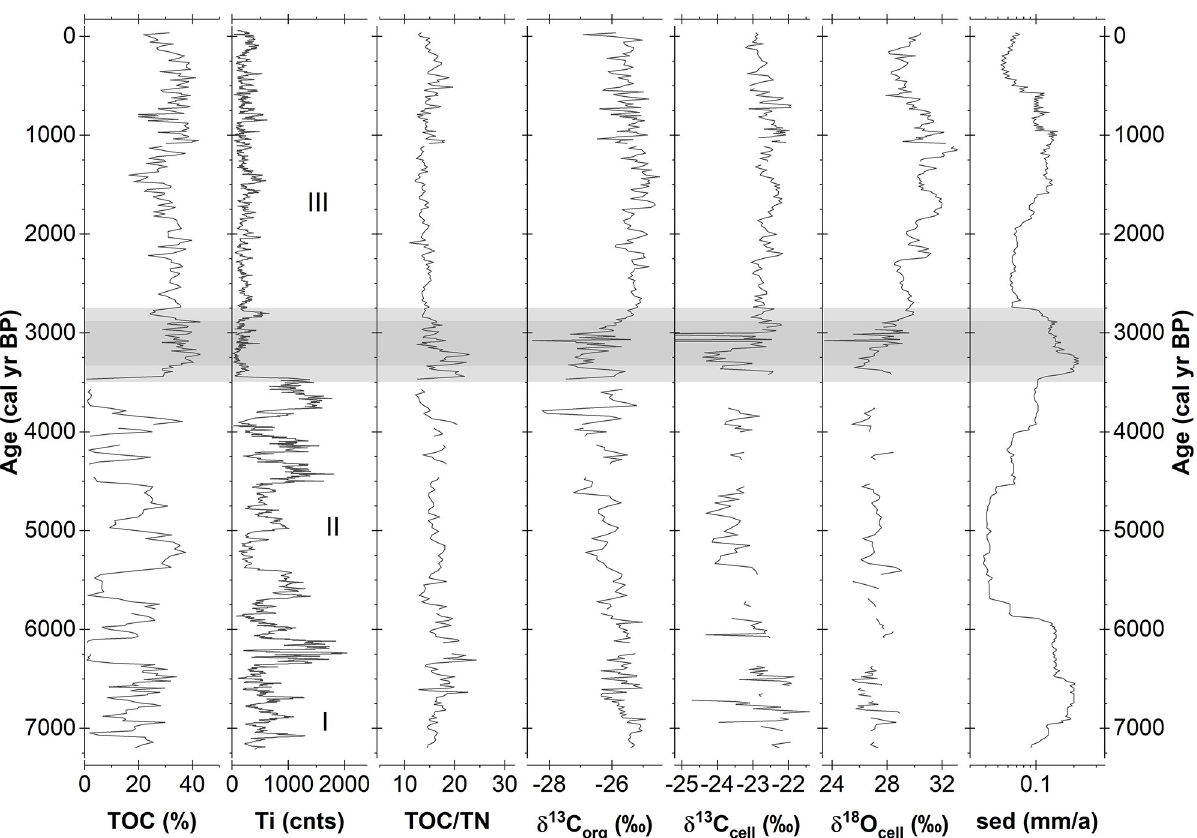
Fig 5. Synthesis of hydroclimatic proxies of the CTP record. Shown are the total organic carbon content (TOC), titanium (Ti), TOC/TN, the stable carbon isotopes of total organic matter ( δ 13 C org ) and cellulose ( δ 13 C cell ), the stable oxygen isotopes of cellulose ( δ 18 O cell ) and the sedimentation rate (sed, log scale). The grey bars indicate the hydroclimatic transition, as mentioned in the